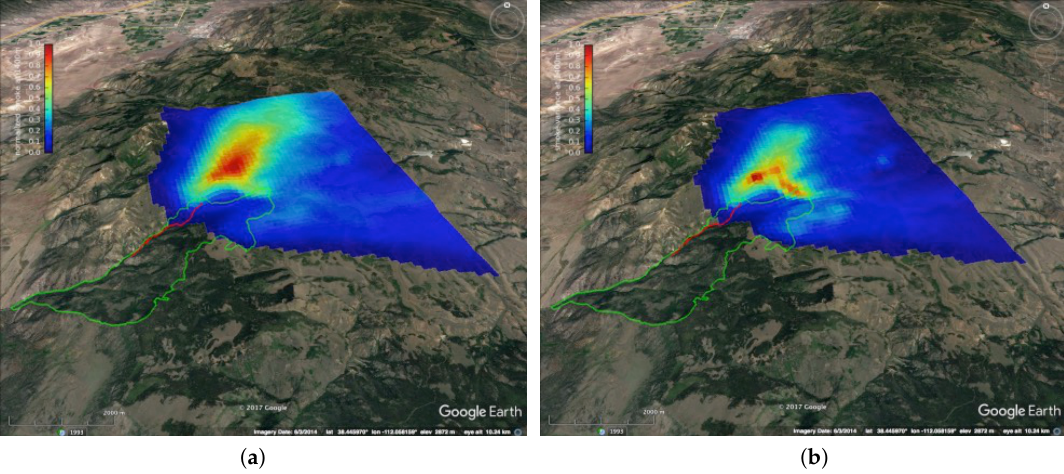
Figure 15. ( a ) The mean normalized smoke concentration at 1400 m above the terrain; ( b ) The normalized smoke concentration average variance at 1400 m above the terrain. The green contour represents the burning plot boundary, the red line shows the